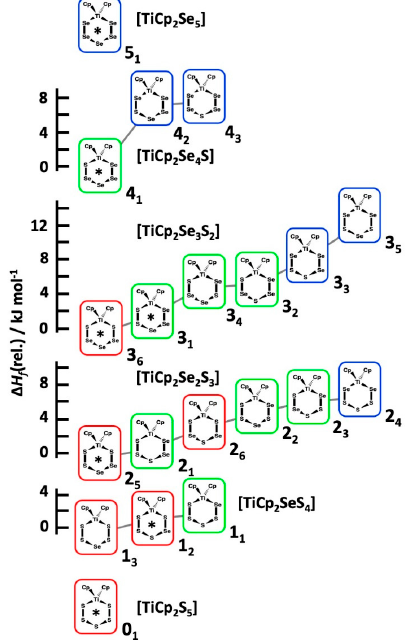
Figure 7. The relative enthalpy of formation of the [TiCp 2 Se x S 5 − x ] isomers of the same composition. The most stable isomer is given the relative value of 0 for each composition. The red frames indicate two Ti–S bonds, green frames one Ti–S and one Ti–Se bond, and the blue frames two Ti–Se bonds. The complexes observed in the reaction mixtures by 77 Se and 13 C NMR spectroscopy have been indicated by an asterisk.